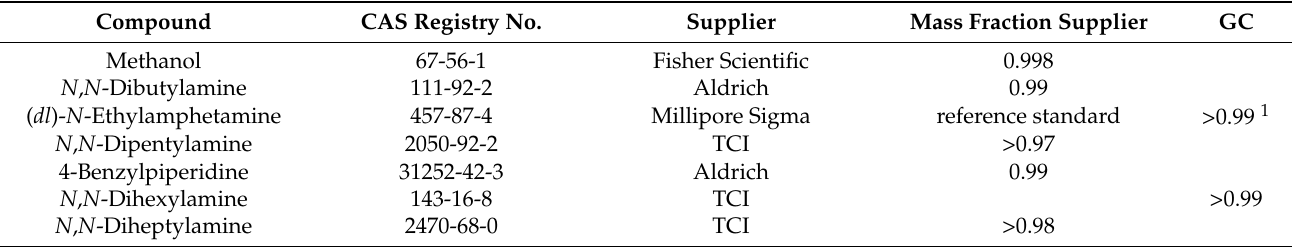
Table 1. Origin of the standards and d -methamphetamine and their analysis. Compound CAS Registry